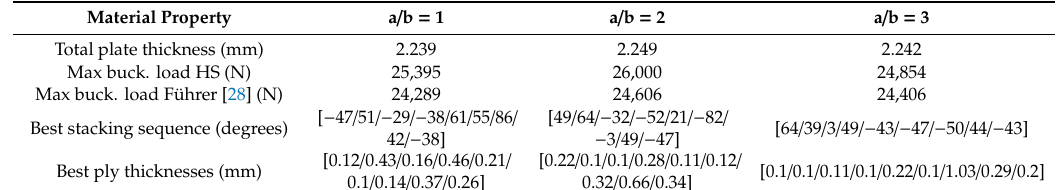
Table 4. The outcome of the harmony search optimisation for the boron / epoxy plates.